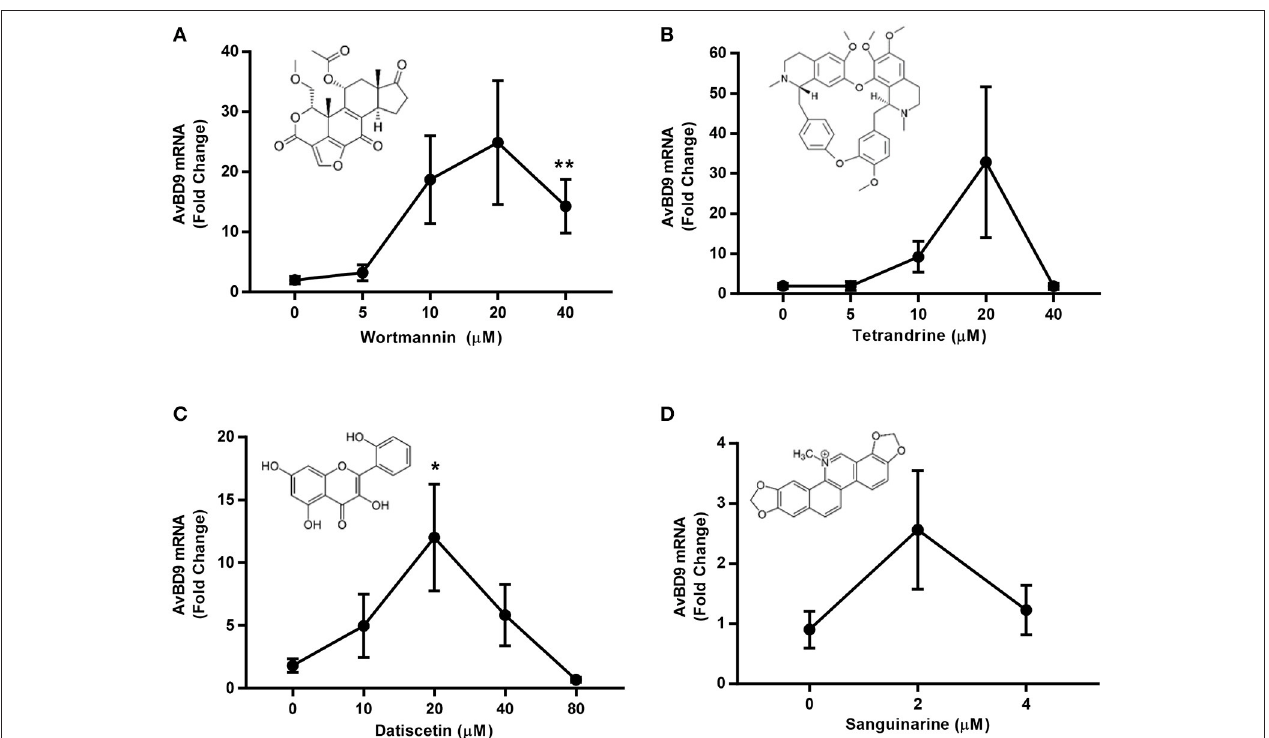
FIGURE 5 | Dose-dependent induction of AvBD9 mRNA expression in response to wortmannin, tetrandrine, datiscetin, and sanguinarine in chicken jejunal explants. Jejunal explants were prepared and treated with different concentrations of each compound for 24h, followed by RT-qPCR analysis of AvBD9 mRNA expression. The results are means ± SEM of 2–3 independent experiments. * P < 0.05 and ** P < 0.01 (by unpaired Student’s t